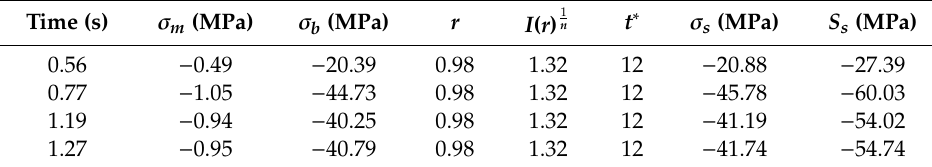
Figure 17. Stress time-history curve. Table 3. Calculation of equivalent structural stress.